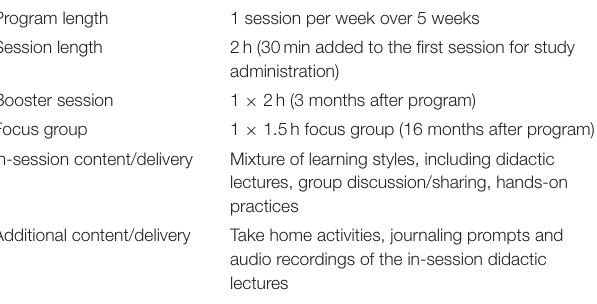
TABLE 3 | Overview of program